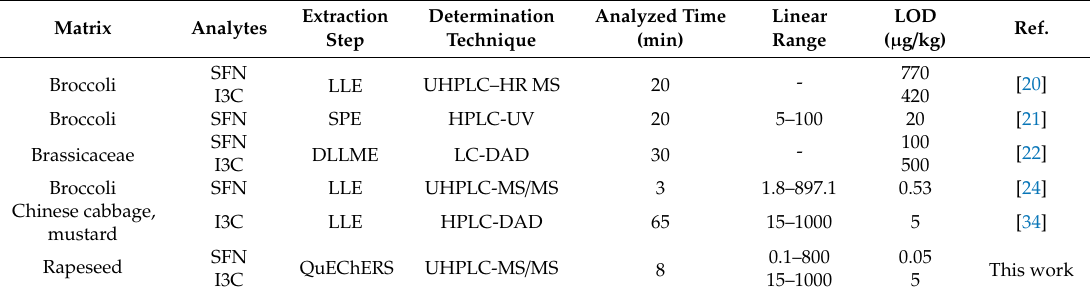
Table 4. Comparison of the extraction step and LOD with the previous